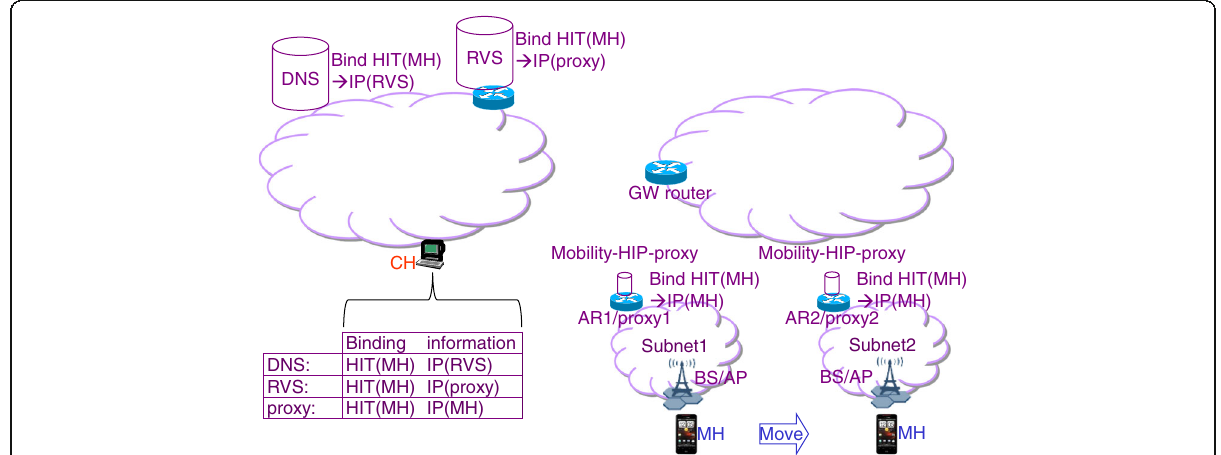
Fig. 2 Design of network-based distributed mobility management and HIP proxy